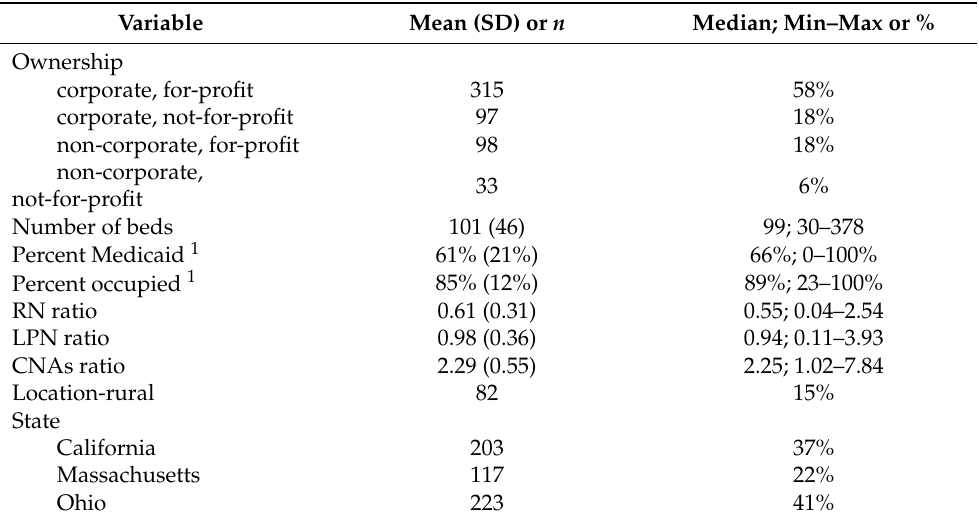
Table 1. Descriptive Statistics of Nursing Home